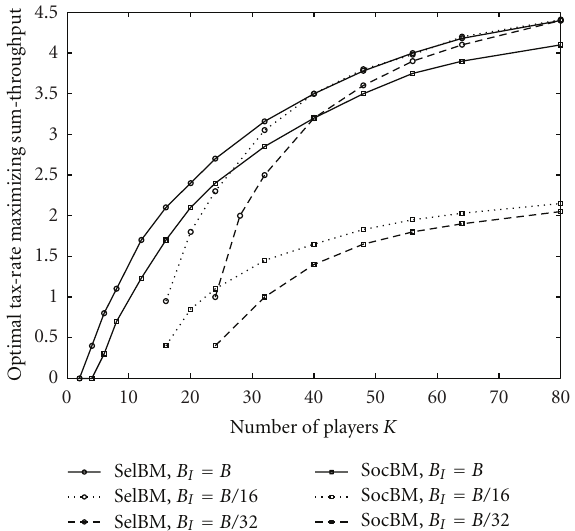
Figure 9: Average sum throughput for the optimal tax rate for both SelBM and SocBM; six-path channel versus the ST 0